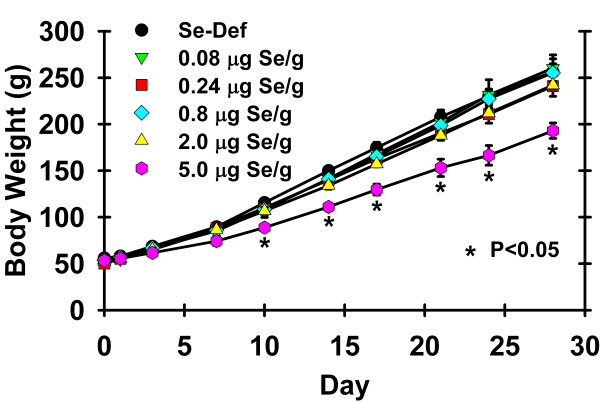
Effect of dietary Se on rat body weight. Male weanling rats were supplemented with 0 to 5 μg Se/g diet for 28 d and weighed bi-weekly. Values are means ± SEM, n = 4/diet. At each timepoint, values marked with an asterisk are significantly different from all other weights (P < 0.05).